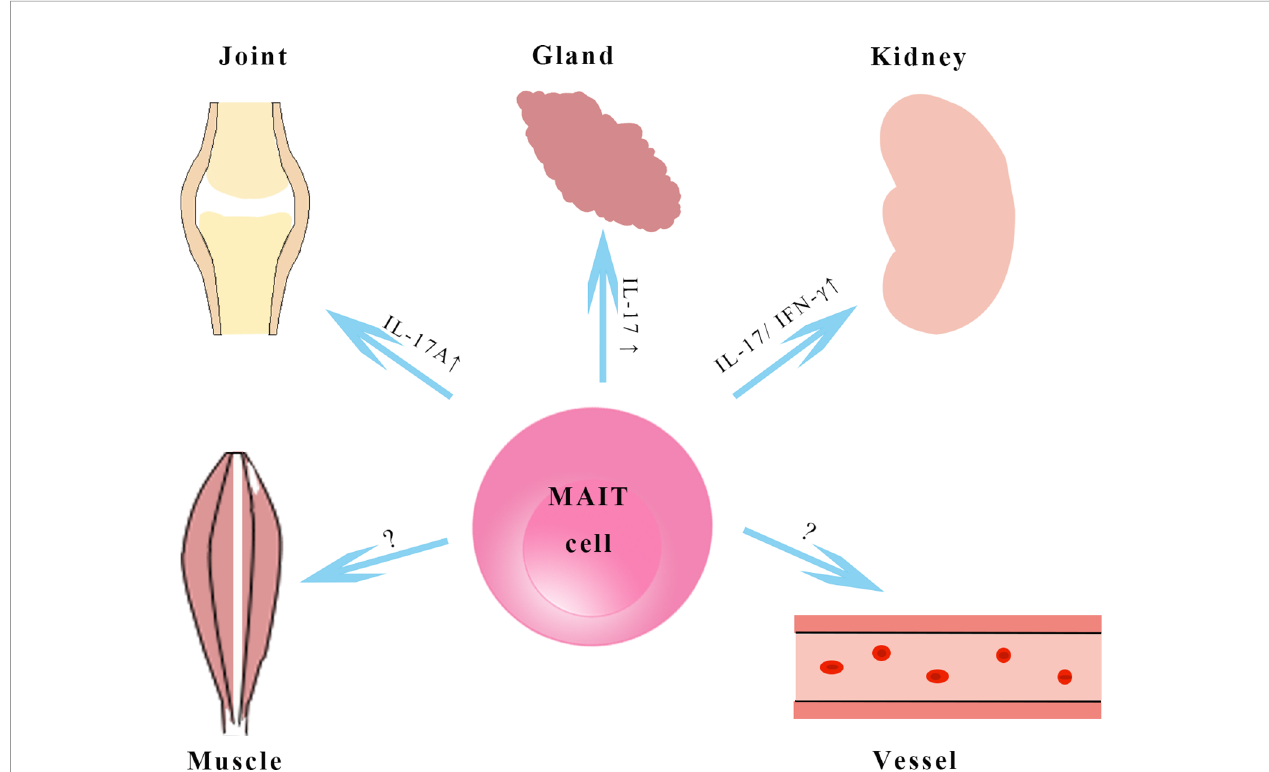
FIGURE 2 | MAIT cells in rheumatological disorders. MAIT cells in kidney, joint, vessels and salivary glands in rheumatic diseases. MAIT cells in tissues produce higher amounts of IL-17 and may exhibit a pathogenic role in animal models with systemic lupus erythematosus and rheumatoid arthritis, however, the functions of MAIT cells in vessels and muscles remain to be elucidated. IL-17, interleukin-17; IFN- g , interferon- g